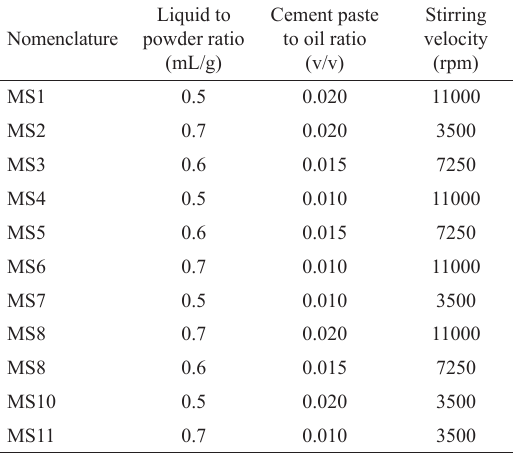
Table 1: Factorial design experiments.